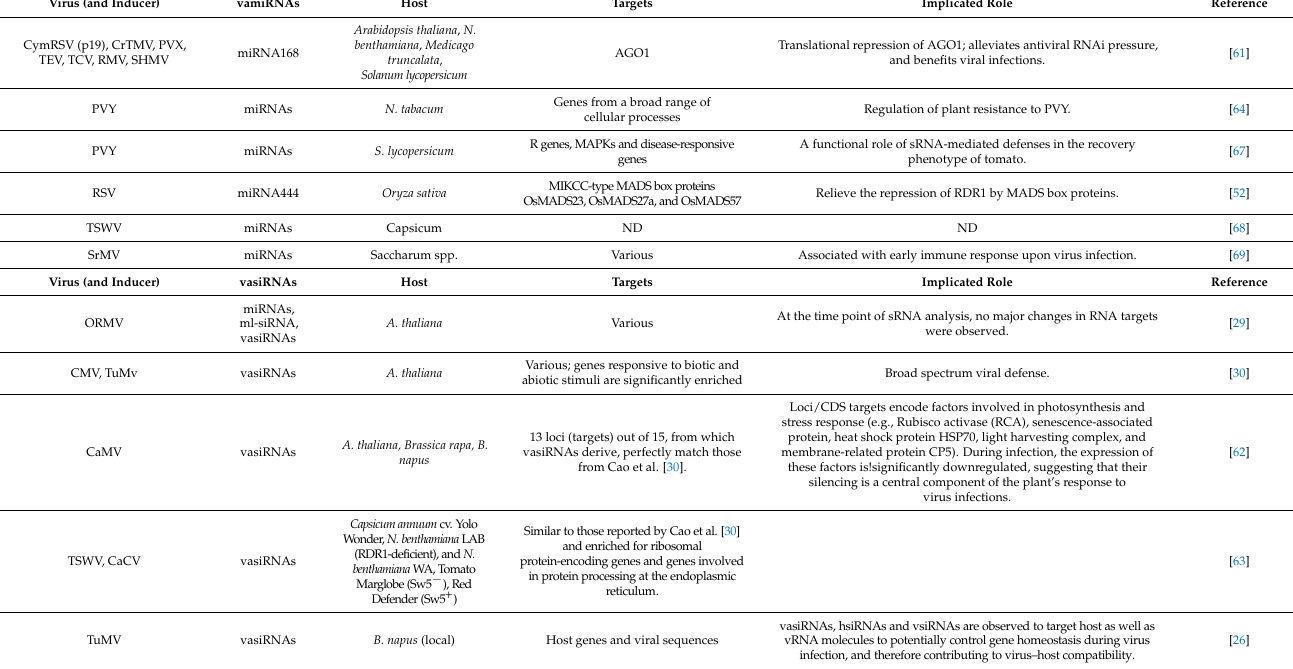
Table 3. Studies reporting viral siRNAs (vsiRNAs), (differentially expressed) viral-activated miRNAs (vamiRNAs), and viral-activated host encoded siRNAs (vasiRNAs) targeting host genes, and their implicated role in the viral–host